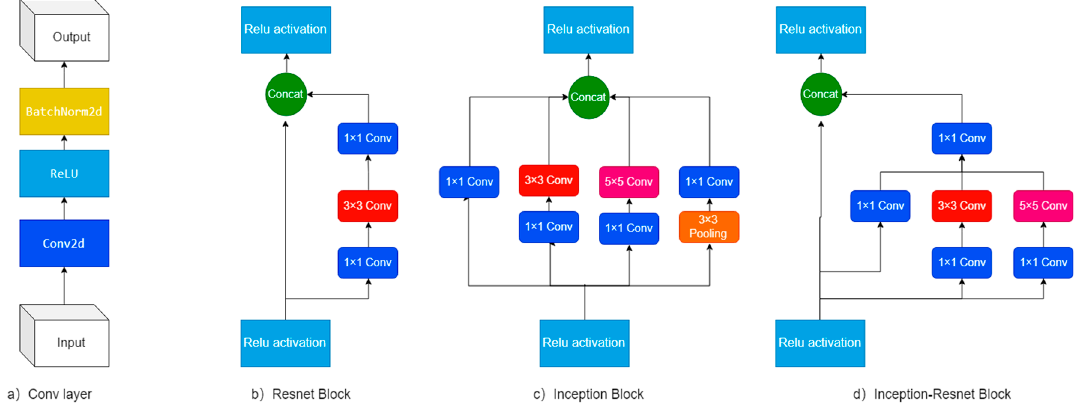
Figure 5. Architectures of ( a ) the convolution layer; ( b ) Resnet block; ( c ) Inception Block, and ( d ) Inception-Resnet Block.